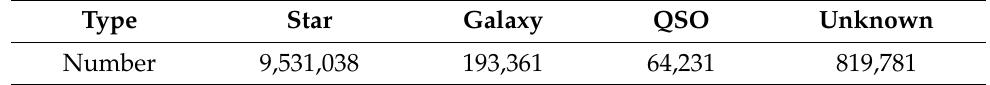
Table 1. The number of four types of